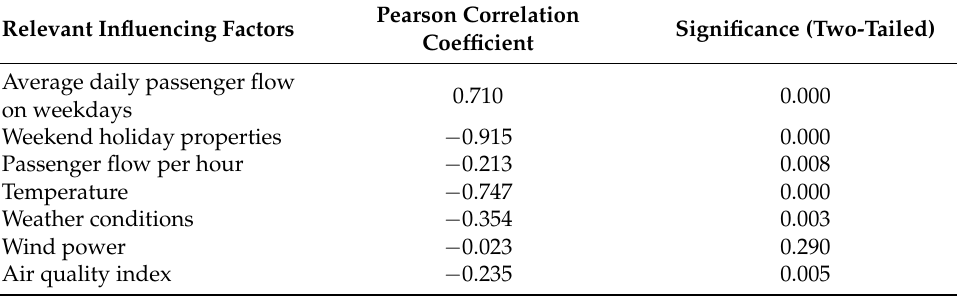
Table 2. Pearson correlation coefficient of factors affecting passenger